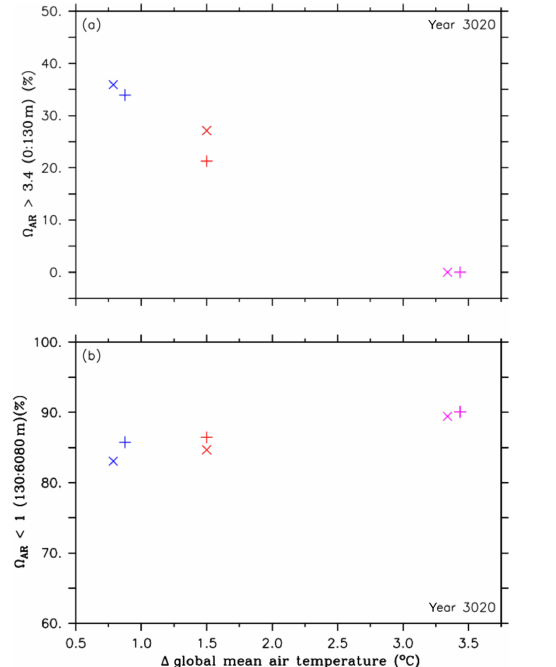
Figure 6. Comparison of volumes for different aragonite satura- tion states and their corresponding global mean temperatures in the year 3020, both relative to preindustrial levels, between the RCP4.5 control simulations (purple symbols), simulations of the second ap- proach (A2, red symbols) and simulations of the third approach (A3, blue symbols). The cross symbols refer to the default simulations, and the X symbols denote simulations with CaCO 3 sediment and weathering feedbacks. These symbols represent (a) omega arago- nite > 3.4 in the upper ocean (0 to 130m depth), relative to prein- dustrial levels, and (b) changes in minimum pH values at 3000m depth, relative to preindustrial